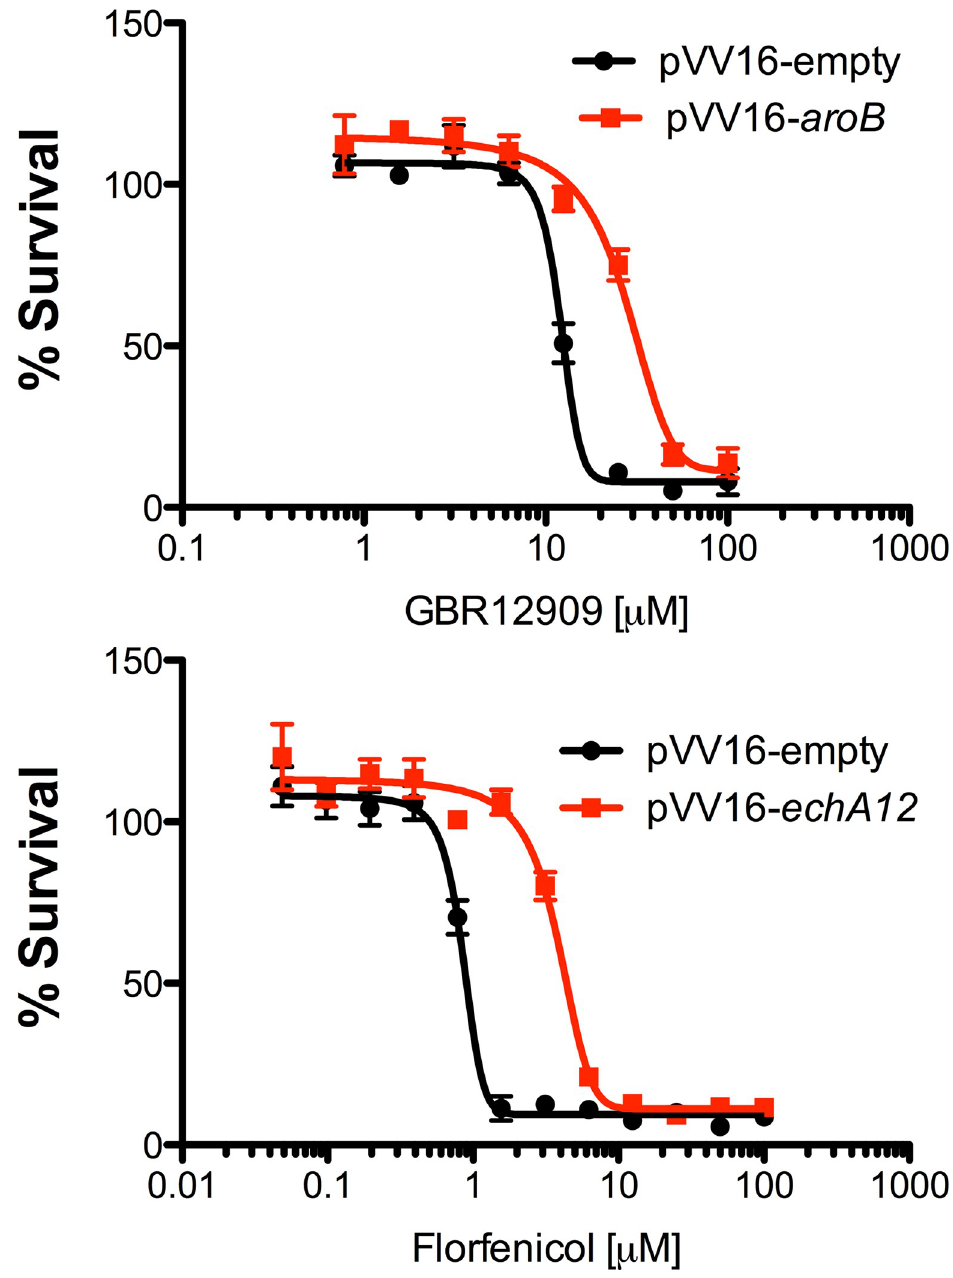
Fig 5. Effect on the MIC of GBR12909 and florfenicol on the over-expression of AroB and EchA12 in BCG. The over-expression constructs pVV16- aroB , pVV16- echA12 and empty pVV16 (control) were electroporated into BCG and the MICs GBR12909 and florfenicol evaluated. The data shows a mean of three replicates and error bars represent the standard deviation. EchA12 in BCG. In the absence of EchA12 over-expression, the MIC of florfenicol remained unchanged with that of wild-type BCG (Fig 5 and Table 3). However, upon over-expression of EchA12, the MIC of florfenicol increased from 0.7 μ M to > 12 μ M (Fig 5) highlighting target engagement of florfenicol with EchA12 as one of its putative targets in mycobacteria. Three